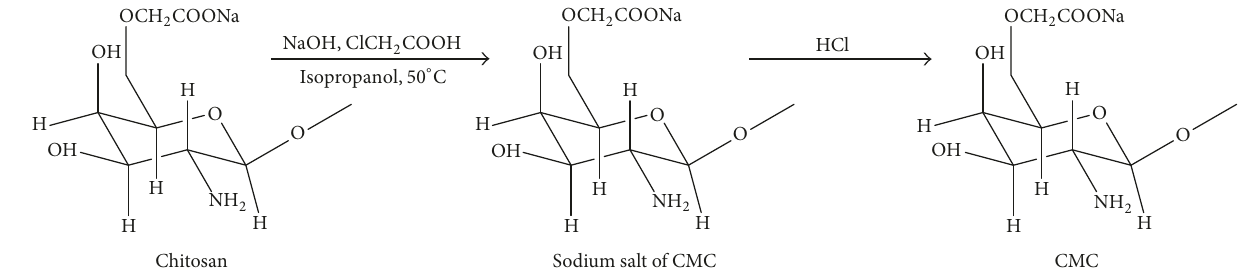
Figure 3: Synthesis of CMC from